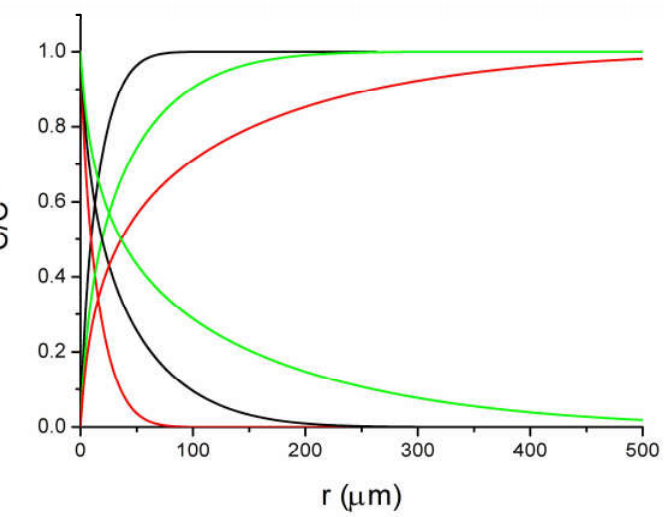
Figure 8. Concentration profiles at a 4.5 mm radius fiber with the parameter of Figure 3. Scan rates: 0.01 (green), 0.1 (black), 1 (red) V s −1 calculated with Kissa 1D.